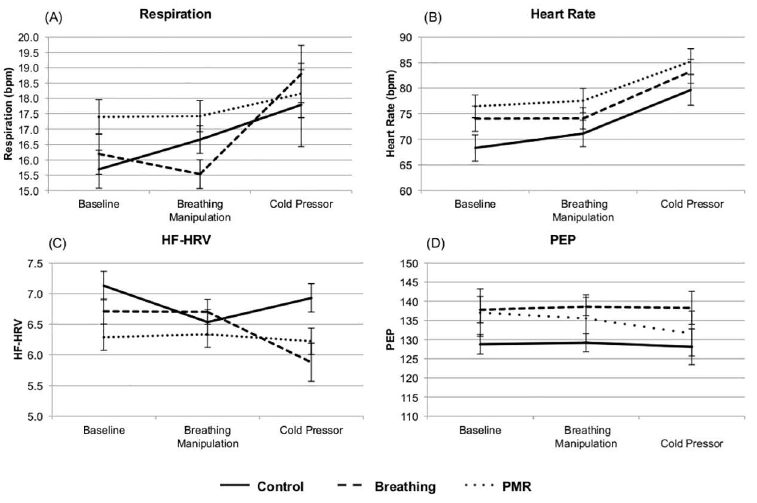
Fig 2. Effects of intervention on cardiac measuresand respiration. Effects of interventionon cardiac measuresand respiration: (A) Respiration, (B) Heart Rate, (C) HF-HRV, (D) PEP. There were no significant effects of interventionon any of the